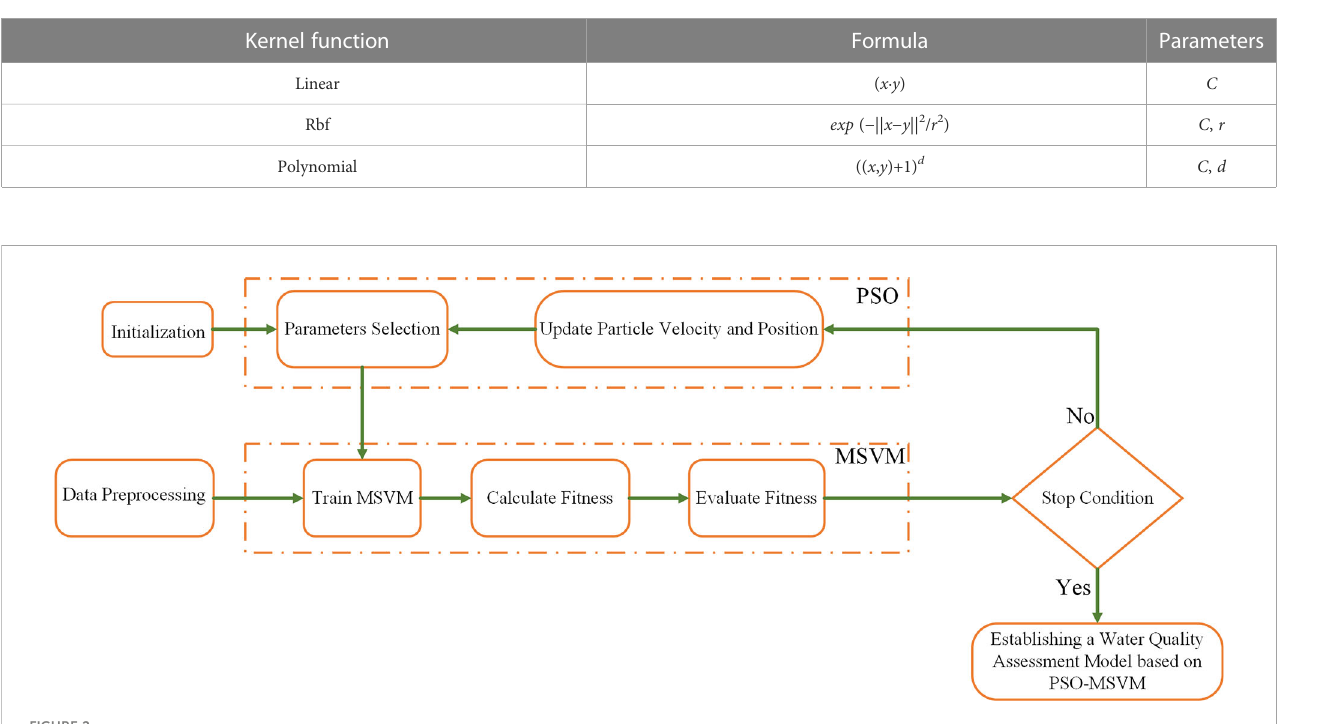
TABLE 3 Kernel function formula and parameters.